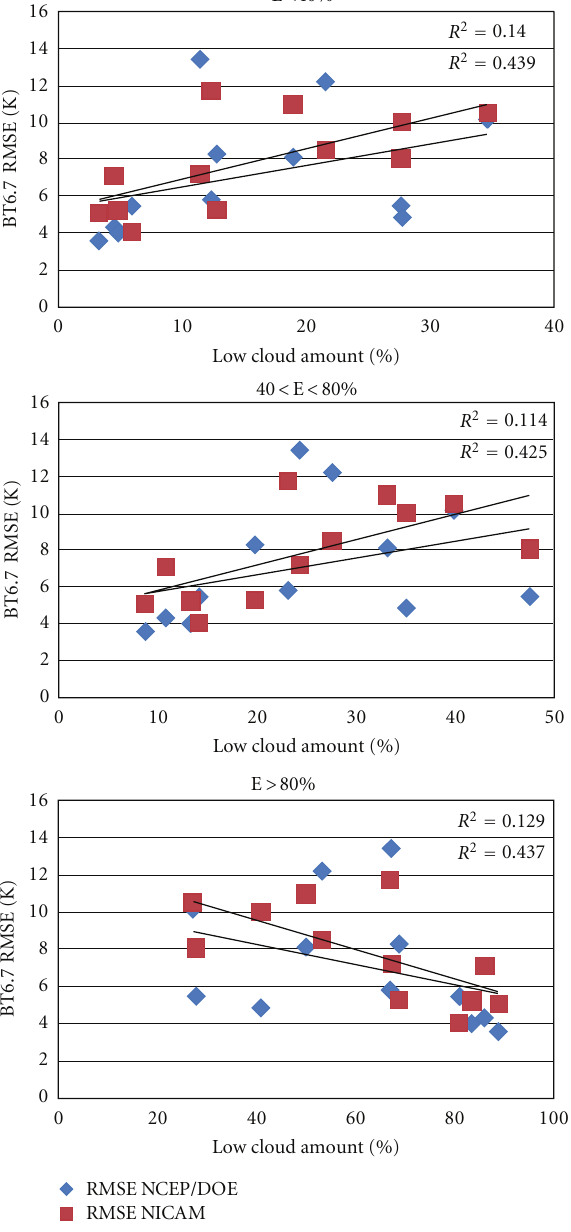
Figure 10: Variation of the amount of low cloud (% of low clouds’ pixels to the sum of clear sky and low clouds) with the brightness temperature at 6.7 μ m (BT6.7) wavelength RMSE for various cloud e ff ective emissivity ( E ) ranges. The determination coe ffi cients on the right in each frame are, respectively, for the relation between the low cloud amount and both the RMSE NCEP/DOE (upper) and RMSE NICAM